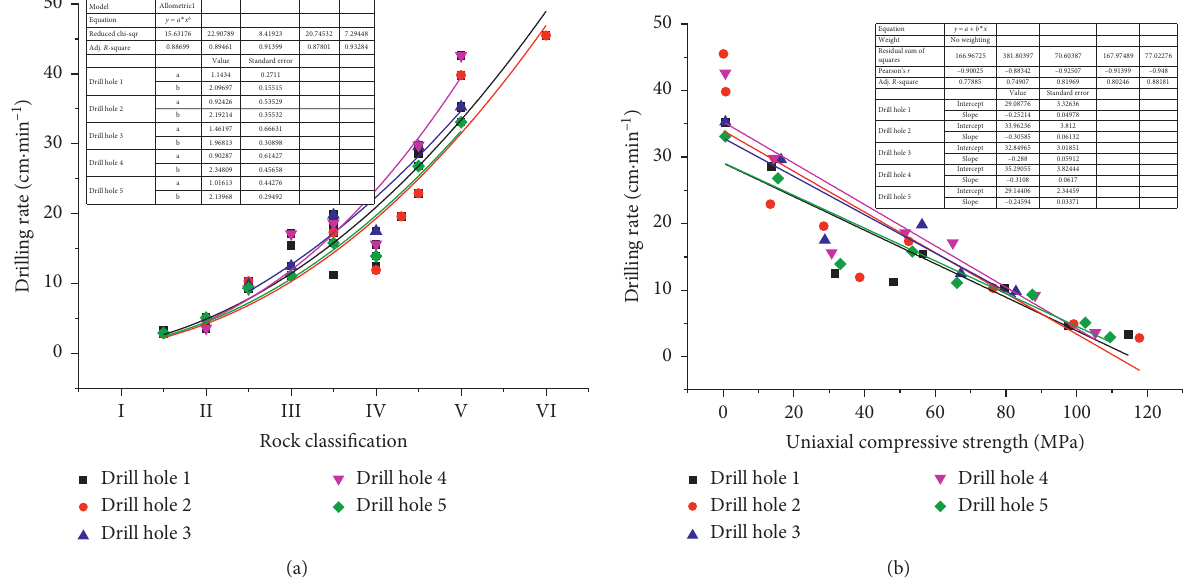
Figure 13: Relationship between rock classification, compressive strength, and drilling rate.